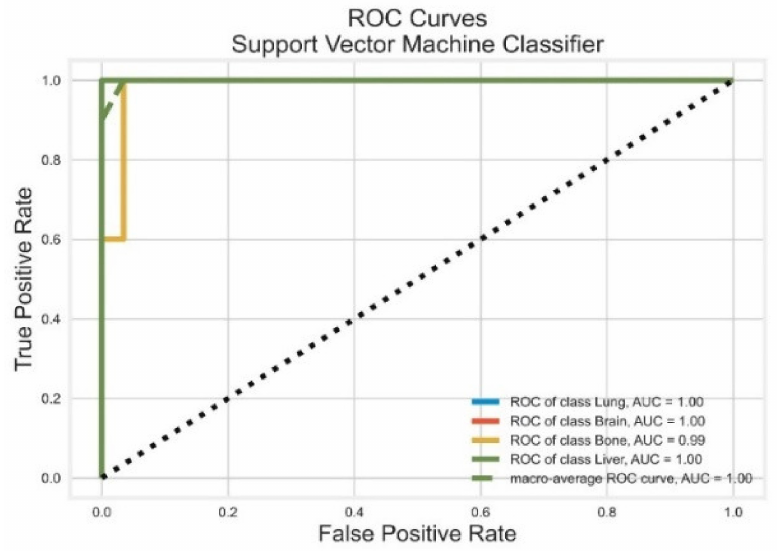
Figure 28. ROC Curves (Support Vector